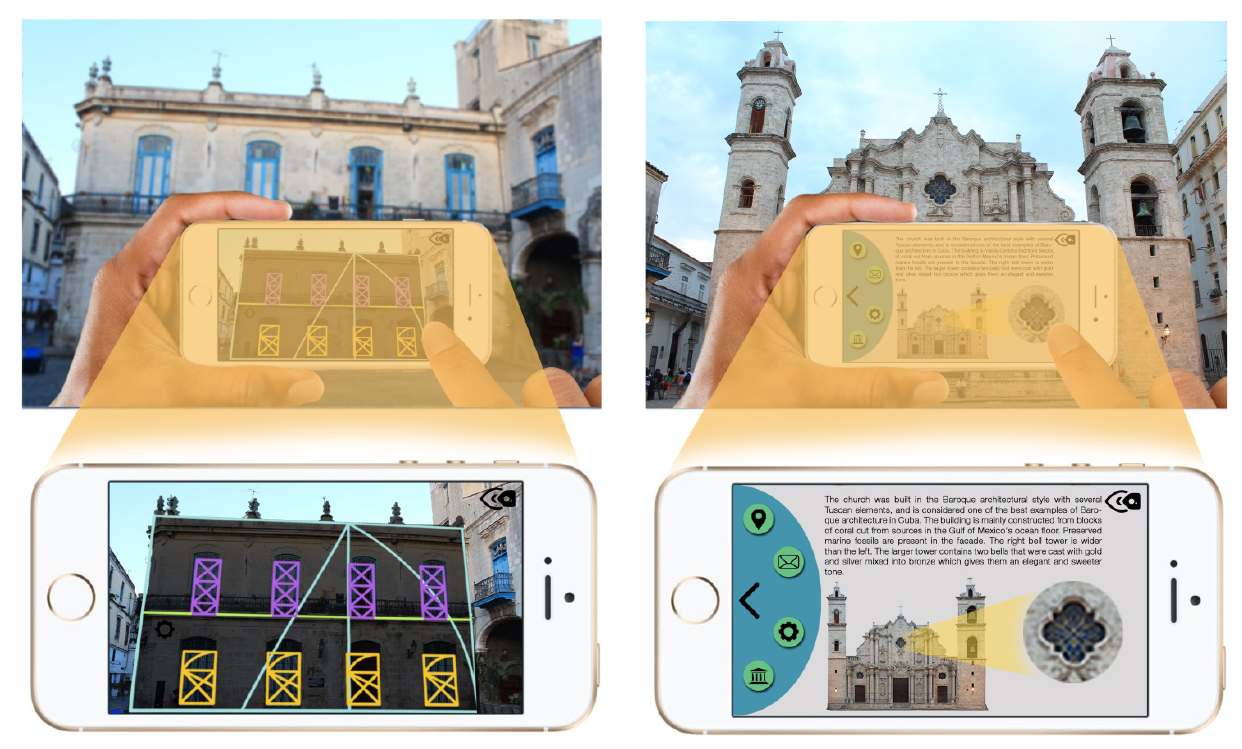
Figure 13. Example of an application of aumented reality (Catedral de la Virgen Maria de la Conceptión Inmaculada - Plaza de la